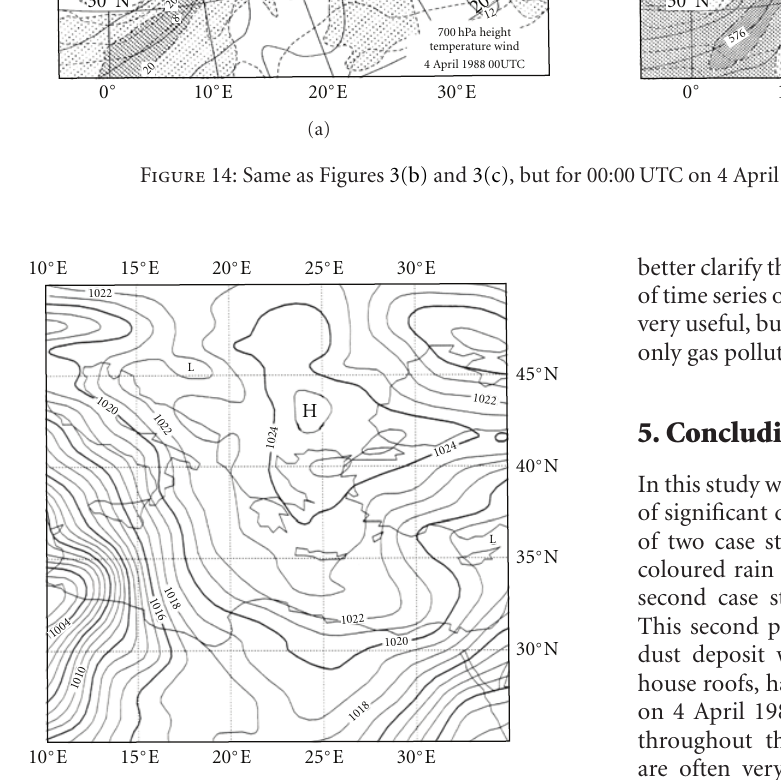
Figure 15: Same as Figure 1, but for 12:00 UTC on 3 April 1988. Isobars: every 1